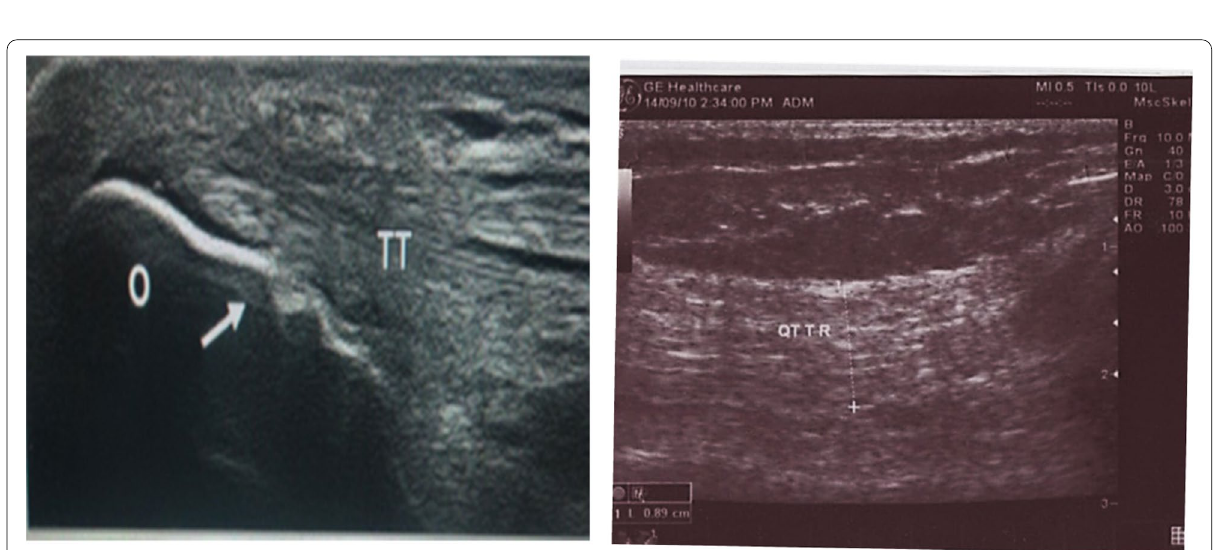
Fig. 2 A Longitudinal B‑mode superficial ultrasound of the elbow at the site of insertion of triceps tendon (TT) at the olecranon (O) showing irregularities and erosion of the olecranon (white arrow). B Longitudinal B‑mode superficial ultrasound at the level of the knee joint showing thickened right quadriceps tendon (QT) (8.9